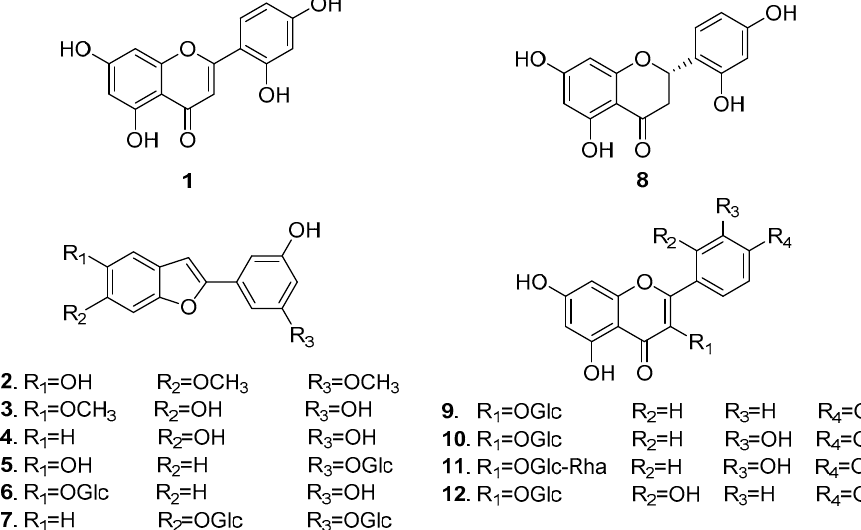
Figure 1. Structures of compounds 1 – 12 from M. alba leaves.